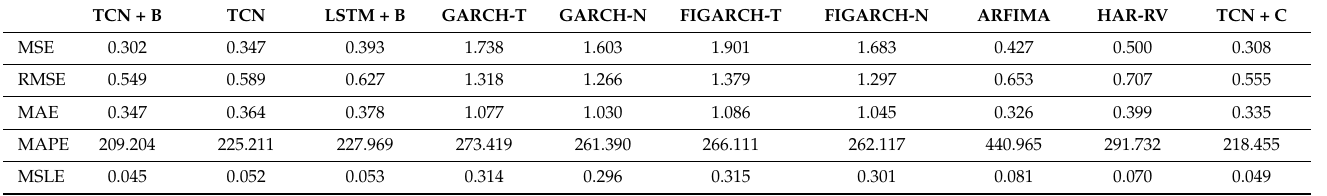
Table 12. Comparison between attention factor model based on cross-correlation coefficient and other models. FIGARCH-T FIGARCH-N ARFIMA HAR-RV TCN + C